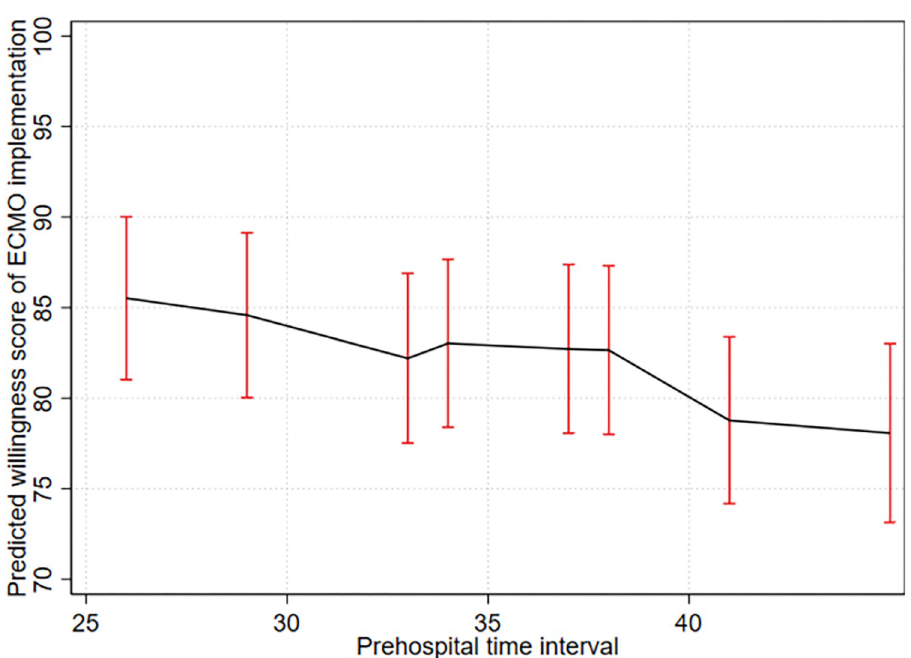
Fig 3. Predicted willingness score for extracorporeal membrane oxygenation (ECMO) implementation based on prehospital time interval.